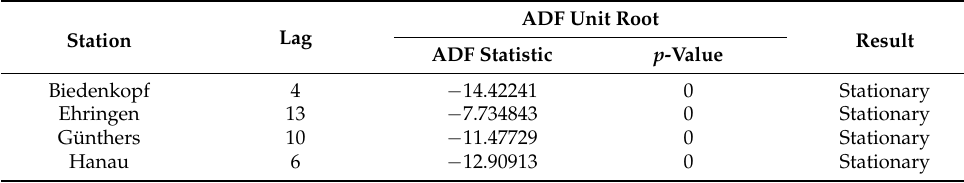
Table 2. Results of ADF test for daily discharge with 95%